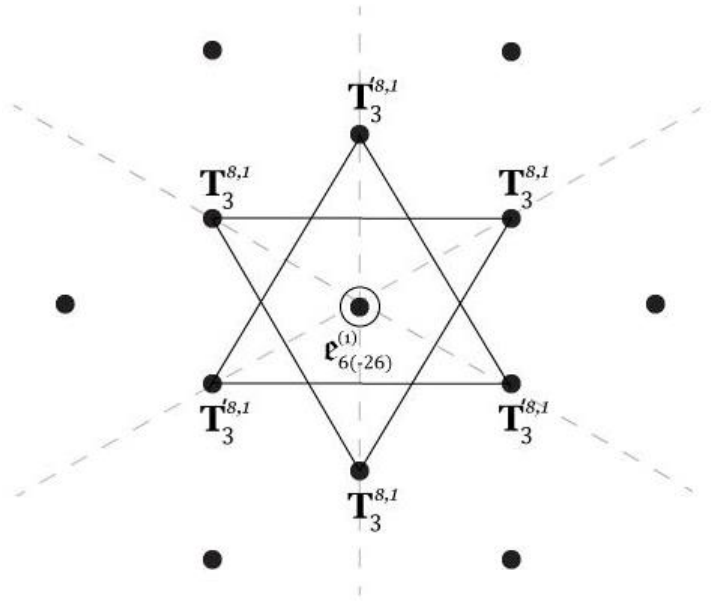
( 1 ) ( 1 ) that contains e in the center, named after the 8 ( − 24 ) 6 ( − 26 )